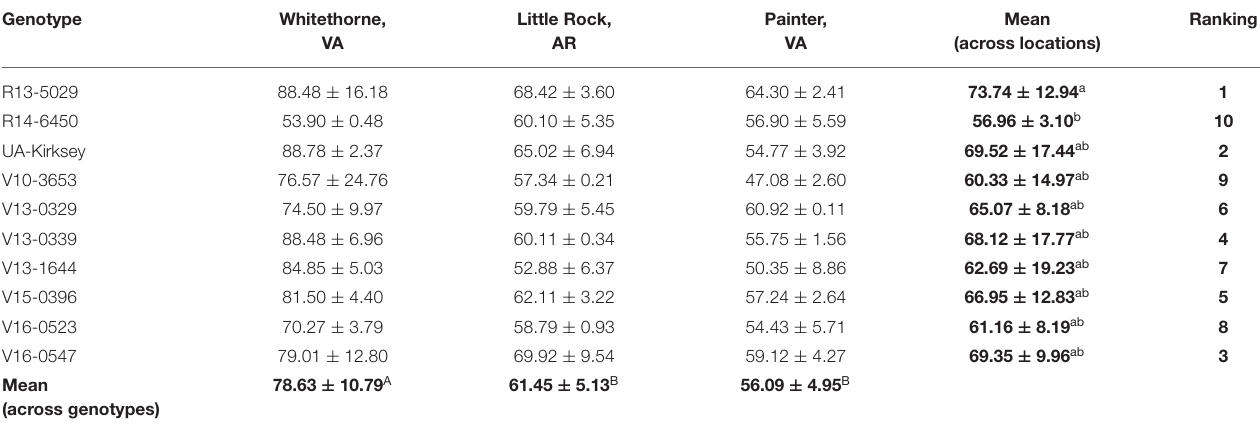
TABLE 4 | Total sweetness (equivalent mg sucrose/g dry matter) of 10 different edamame genotypes planted in different locations.